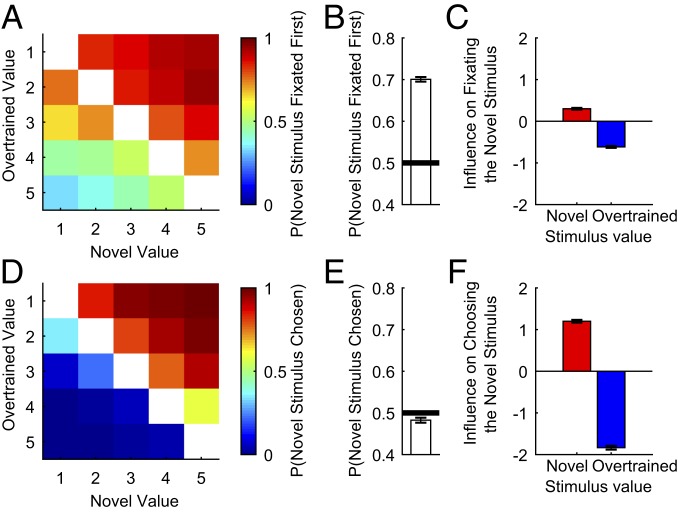
Dissociation between fixation and choice behavior on mixed trials. When choosing between a novel and overtrained stimulus, subjects prefer to fixate the novel stimulus first but not to choose it. (A) The proportion of trials where subjects viewed the novel stimulus first, as a function of novel and overtrained stimulus values. Subjects preferred to fixate the novel stimulus first, but fixations were still influenced by stimulus value. (B) Proportion of trials where subjects viewed the novel stimulus first. (C) Logistic regression coefficients for the influence of stimulus value on the probability of fixating the novel stimulus first. (D) The proportion of trials where subjects chose the novel stimulus, as a function of the novel and overtrained stimulus values. There is no preference for choosing the novel stimulus; choices are strongly influenced by value alone. (E) Proportion of trials where subjects chose the novel stimulus. (F) Logistic regression coefficients for the influence of stimulus value on the probability of choosing the novel stimulus. All error bars denote SE.